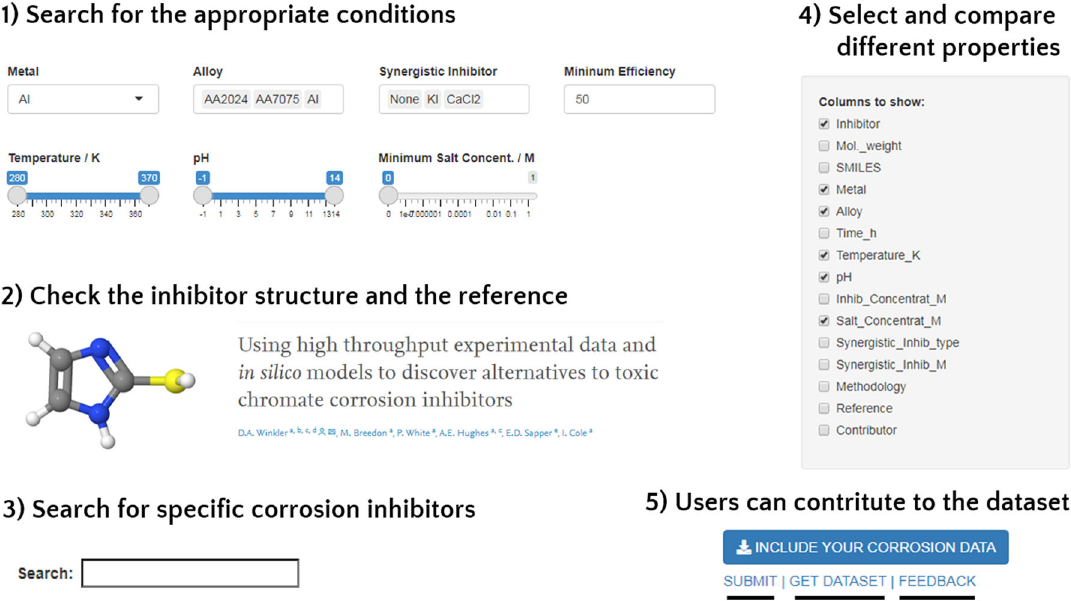
Fig. 2 Main features of the CORDATA web application. The CORDATA application includes (1) digital features to search the appropriate application conditions of the corrosion inhibitors, (2) the possibility to check the inhibitor structure and the respective literature reference, (3) an embedded search engine to search for speci fi c corrosion inhibitors, (4) an option to visualize additional properties, and (5) instructions for users to contribute with data and feedback. npj Materials Degradation (2022) 48 Published in partnership with CSCP and